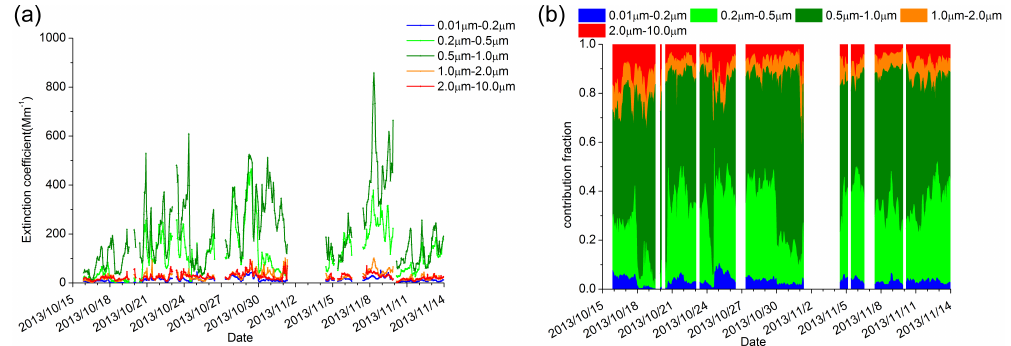
Figure 7. Time series (a) and the relative contributing fraction (b) of different size segments to the dry aerosol extinction coefficient.